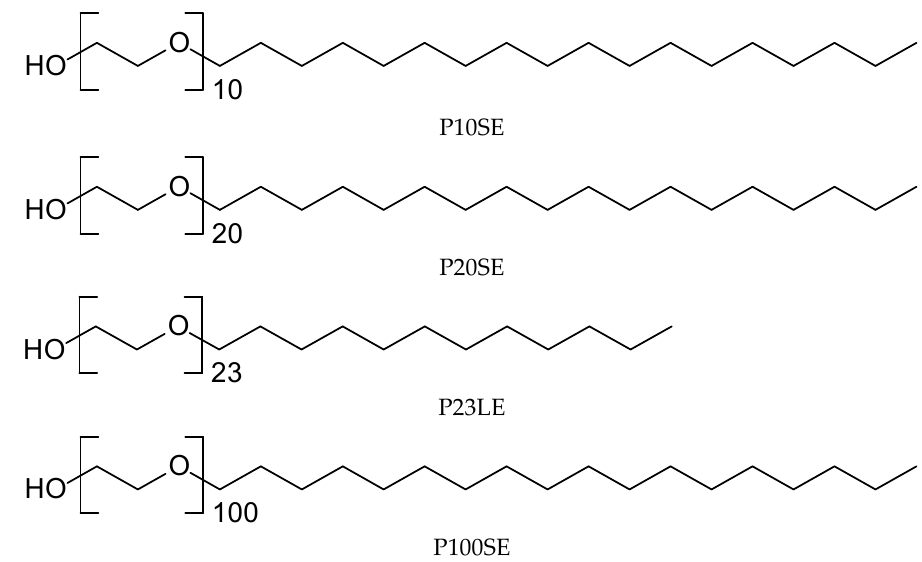
Figure 1. Molecular structures of ethylene glycol alkyl ether emulsifiers.